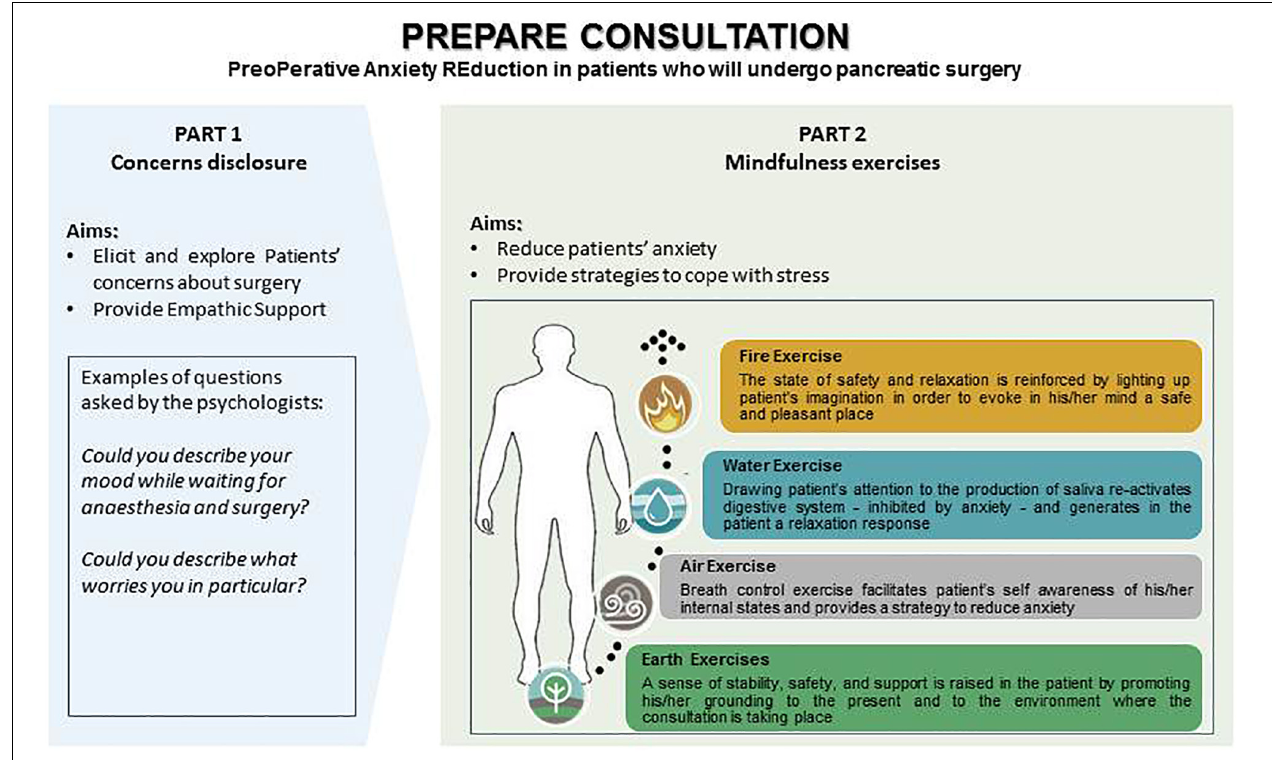
At the end of the consultation, patients were provided with a red stamp to be applied on the identification bracelet, which acted as a reminder to practice the exercise during moments of greater stress. The red stamp was intended to anchor patients (Kabat-Zinn,